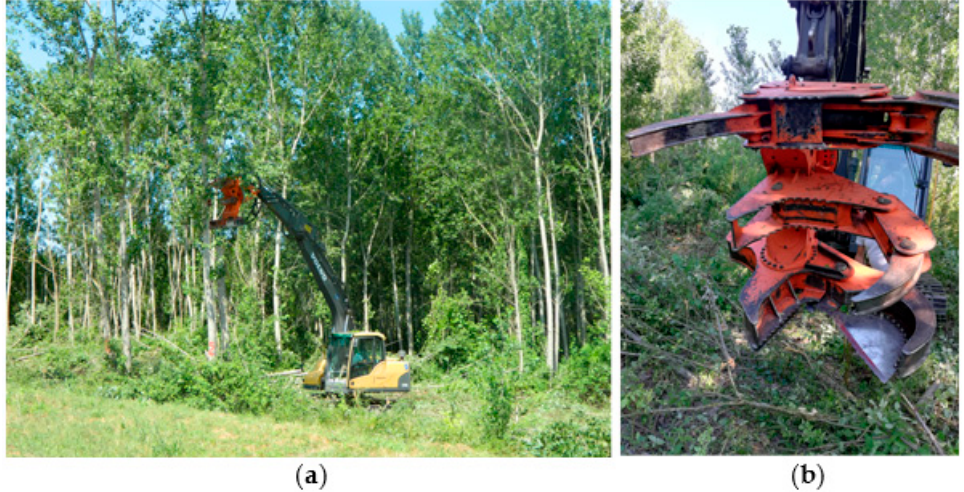
Figure 1. Crawler excavator during the felling of a 11-year-old tree ( a ) and details of the shear head ( b ).